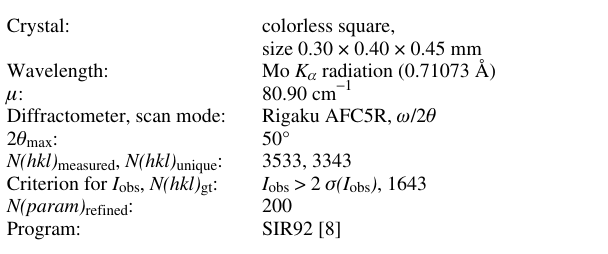
lengths are affected by the interactions with these groups. The proximate bonds ( d (C1—C2) = 1.528(4) Å and d (C1—C3) = 1.556(4)Å)ofthecyclopropaneringbearingthephenylgroupare significantly elongated by 0.04 Å (mean values) compared to the distal bond ( d (C2—C3) = 1.491(4) Å) which has the normal bond length (1.497 Å) [7]. The difference between the proximal bond lengths C1—C2 and C1—C3 demonstrate not only the difference between the electronic effect of the vinyl group and the phenyl group with its synchronous orientation, but also the steric clash between the cyano group and these groups. The angle at the point of the cyano group is smaller than the other two angles ( ∠ C2 − C1 − C3 = 57.8(2)° vs. ∠ C1 − C3 − C2 = 60.2(2)° and ∠ C1 − C2 − C3 = 62.0(2)°). Table 1. Data collection and handling.